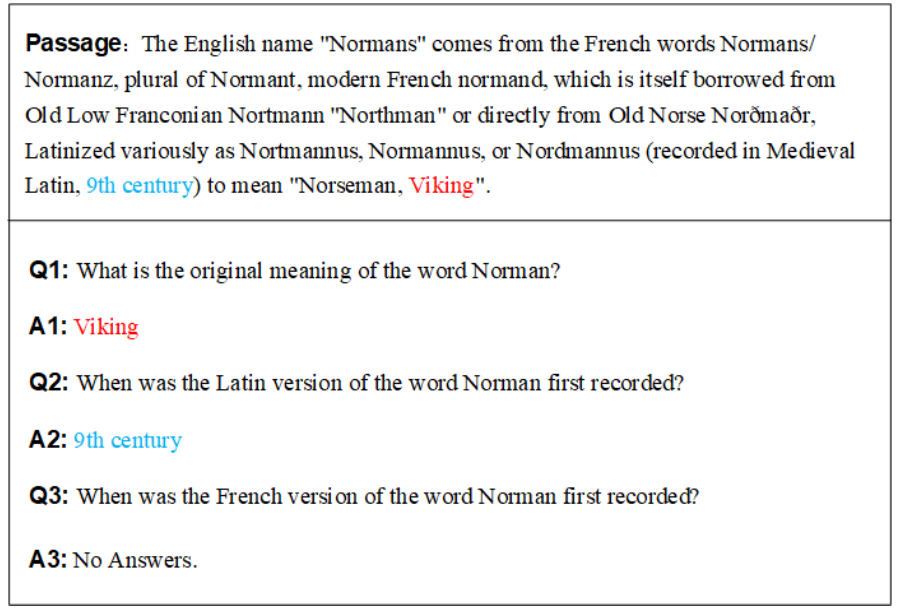
Figure 1. Question–answer pairs of SQuAD2.0. In this dataset, except the answer is No answer, other answers can be found in the